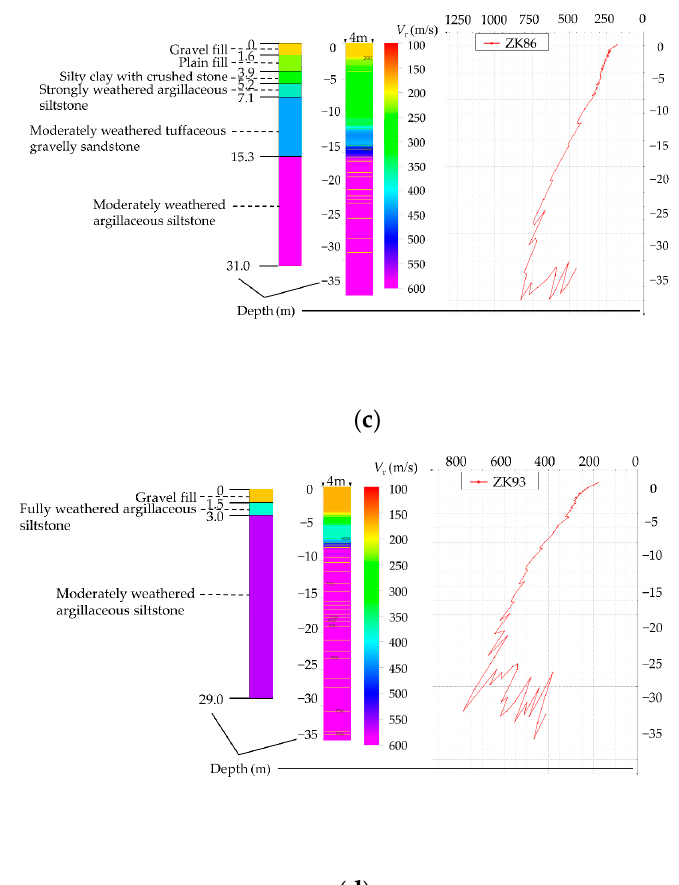
Figure 6. Comparison between microtremor exploration results and drilling geological results: ( a ) ZK082; ( b ) ZK085; ( c ) ZK086; ( d ) ZK093.